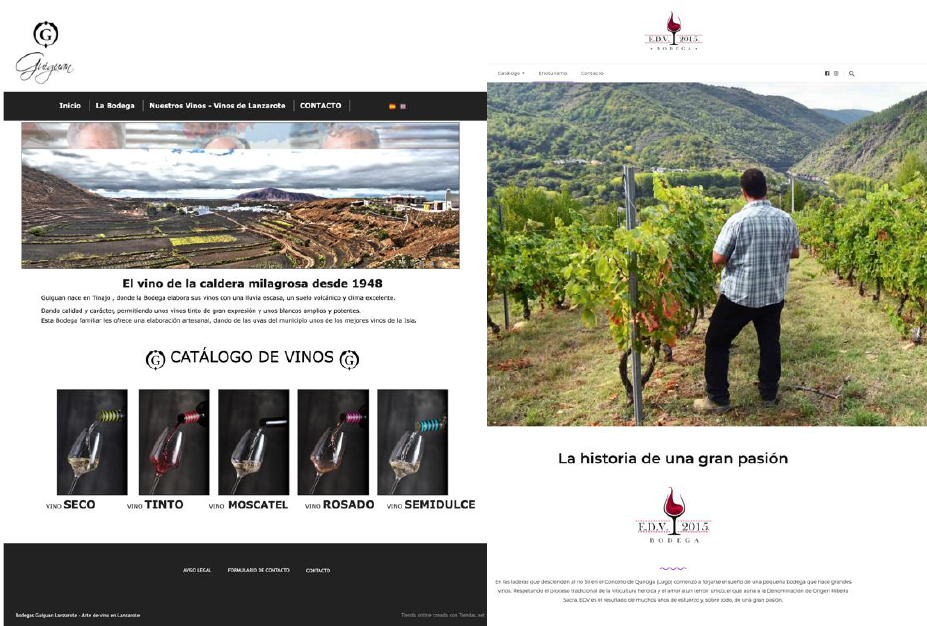
Figure 4. Example of websites in the Lanzarote and Ribeira Sacra AOs. Source: Wineries’ websites.